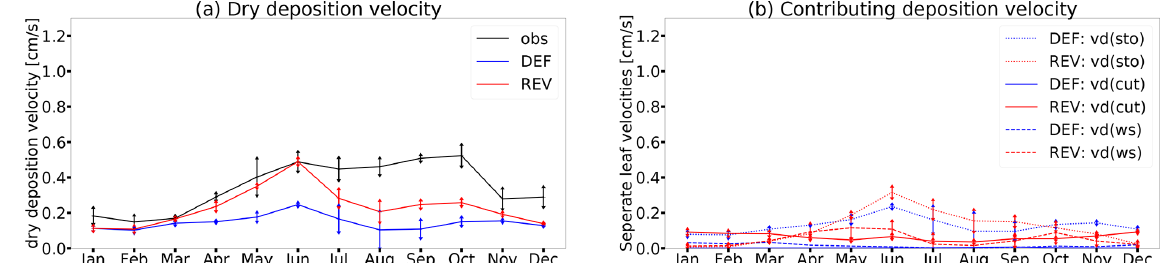
Figure B1. Measured and modelled (DEF, REV) annual cycles at Borden forest.